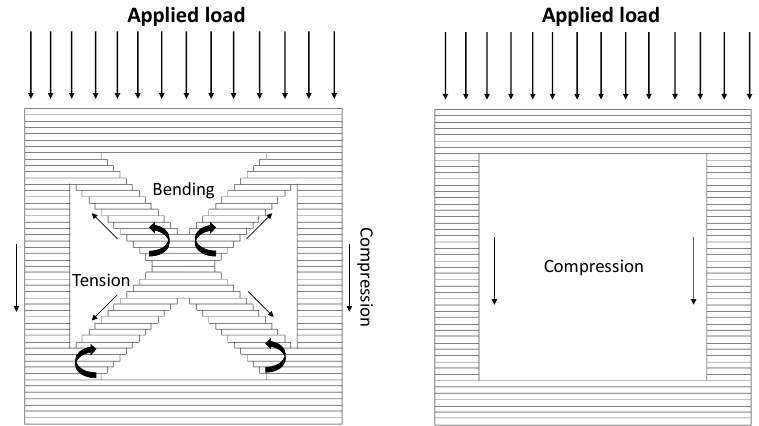
Figure 3. The number of beams oriented in vertical, horizontal, and inclined directions of different lattice morphologies.